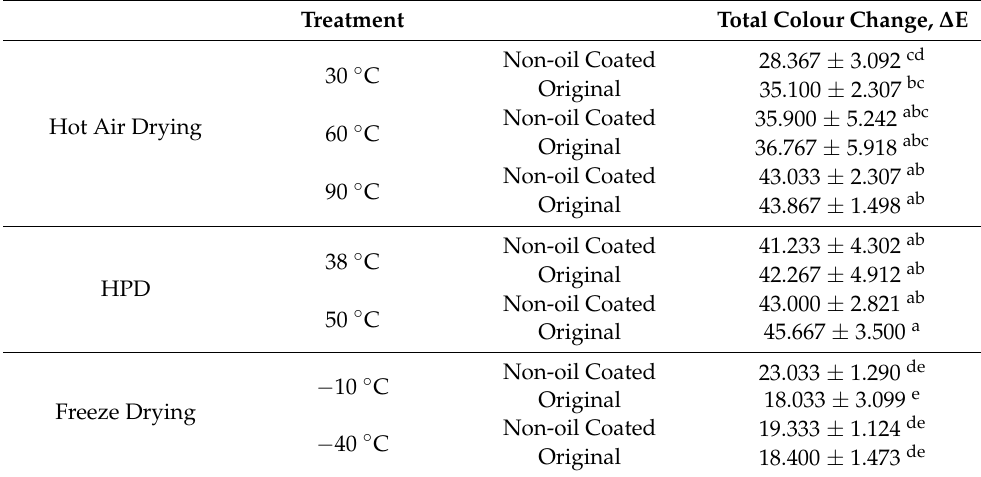
Table 2. Colour parameters of rice noodle sample at different drying procedures. Means of total colour change that do not share a letter in the superscripts are significantly different. Treatment Total Colour Change, ∆ E